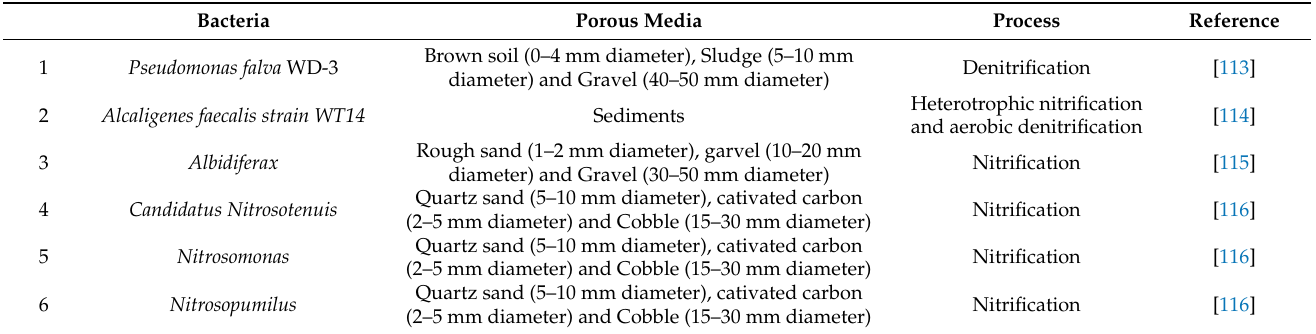
Table 4. Bacterial strains involved in nitrification and denitrification in constructed